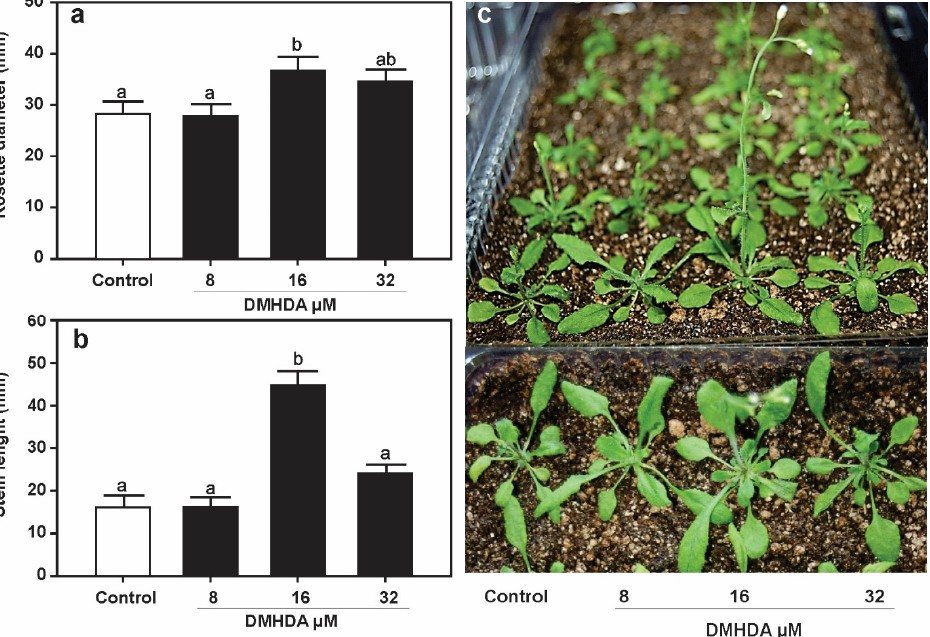
Figure 6. DMHDA generates long-lasting effects throughout the life cycle of A. thaliana . A. thaliana seedlings were germinated for 72 h with DMHDA (0, 8, 16, 32 µ M), and then transferred to 0.2 × MS DMHDA-free plates; after ten days, plants were transplanted to substrate mixture to complete their life cycle, after three weeks rosette diameter ( a ) and stem length ( b ) were recorded, and representative photographs ( c ) were obtained. Values represent the means of 20 replicates ± SE. Different letters represent means that are statistically different (Duncan ´ s test; p < 0.05). Plants 2023 , 12 , x FOR PEER REVIEW